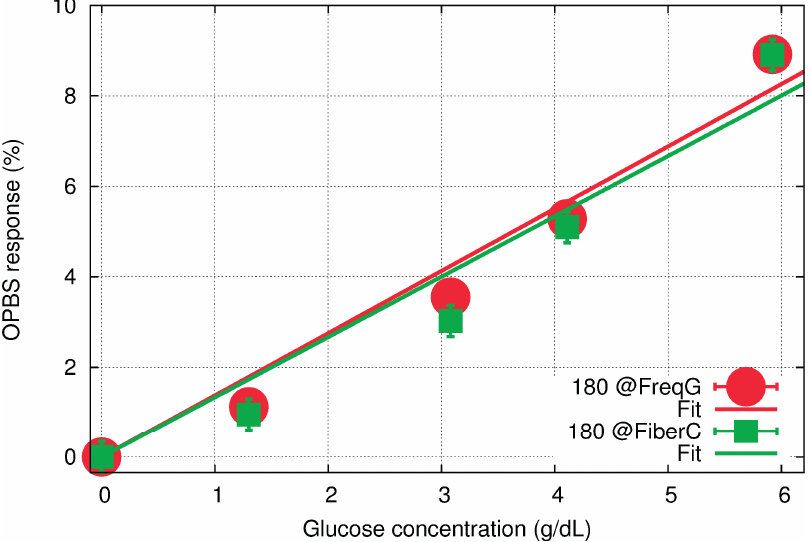
Figure 8. OPBS-based sensor response to aqueous glucose concentration for 180-phase difference set at the FG (red) and the fiber coupler (green), and their corresponding linear regression